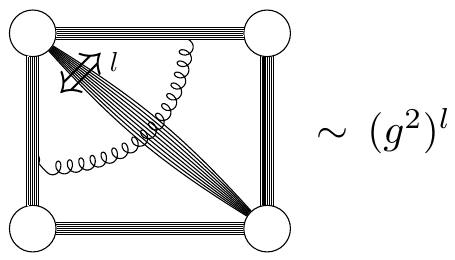
Figure 1 . Saturation: an R-charge factor ( d ij ) l requires a “bridge” made of l propagators and cannot be crossed without paying a factor ( g 2 ) l